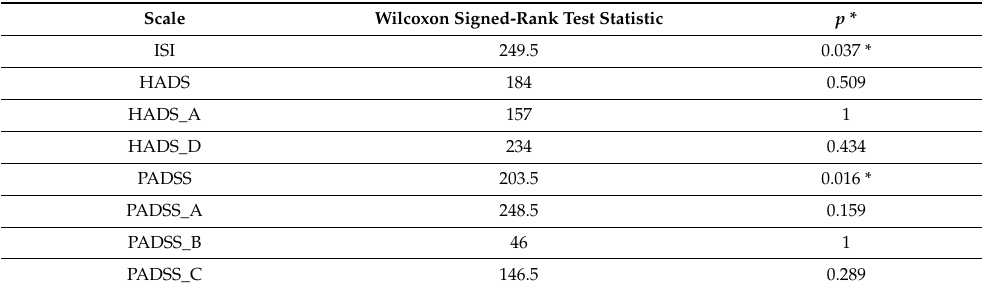
Table 5. Comparisons of pre-treatment (before CBT-NREMP intervention) and post-treatment (after CBT-NREMP intervention) timepoints for scales of: ISI, HADS and PADSS, using Wilcoxon signed rank test for non-responders ( n = 34).